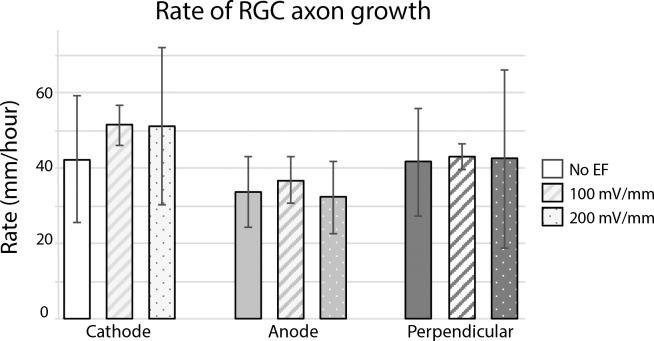
EF does not affect rate of RGC axon growth. Retinal explant cultures were grown for 18 hours, then exposed to an EF of 100 or 200 mV/mm for 5 hours. Rate of RGC axon growth was assessed by measuring maximum length of observed growth and time to maximal length (see Methods). No difference in rate of growth was noted in EF-treated axons compared to control cultures. Error bars represent SD.